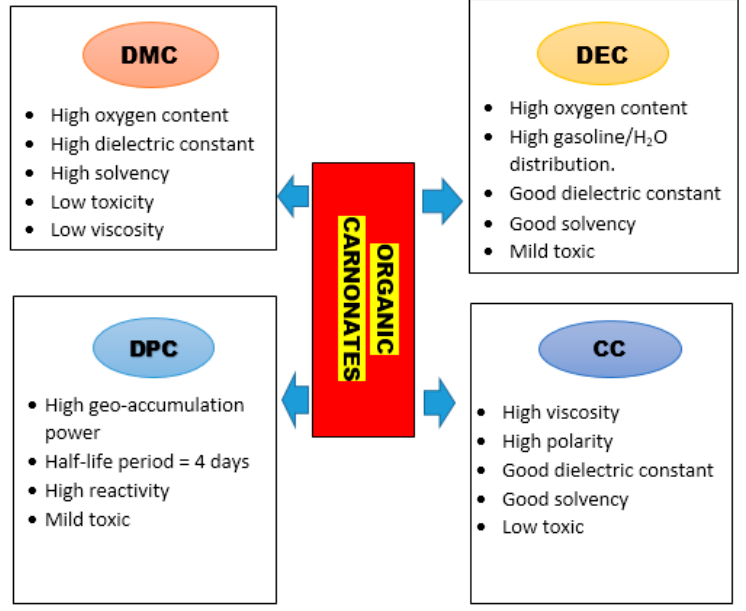
Figure 6. The properties of various organic carbonates (Adapted from [80]).